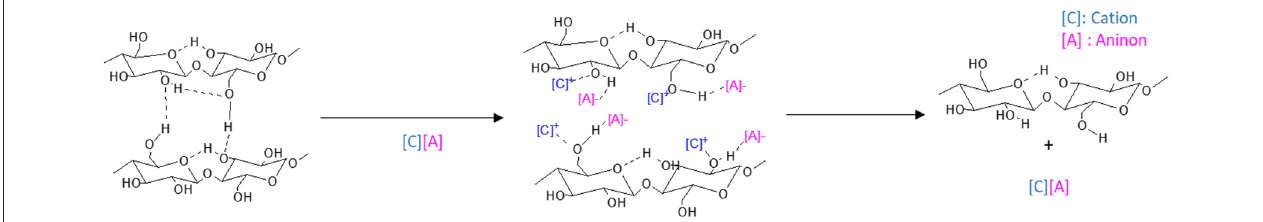
FIGURE 3 | Interruption of intra- and intermolecular H-bonding in cellulose by ILs.